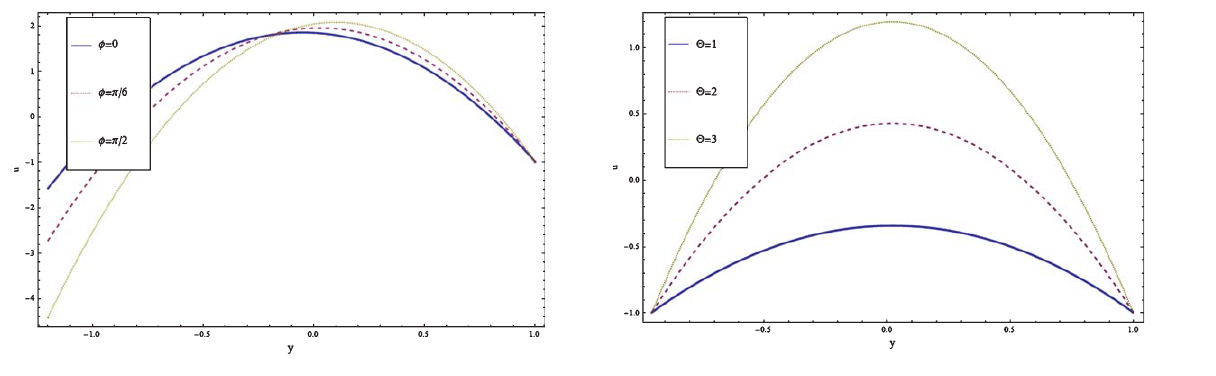
Fig. 5. Plot showing u versus y . Here a = 0 . 6, b = 0 . 3, d = 1 . 1, φ = π/ 6, n = 0 . 398, x = 0 . 25 and We = 0 . 4.